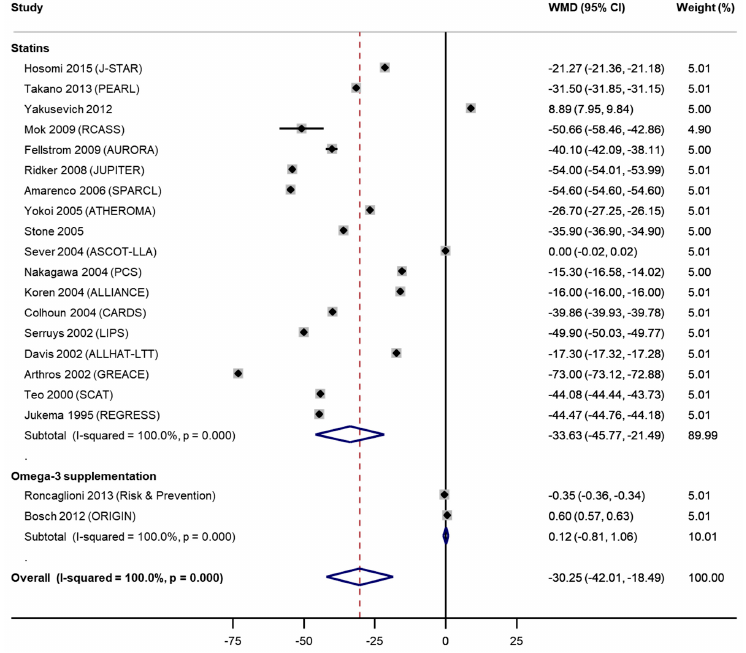
Figure A1. Meta-analysis for LDL-C lowering effect of statins and omega-3 supplementation. WMD, weighted mean difference; CI, confidence interval; LDL-C, low-density lipoprotein cholesterol